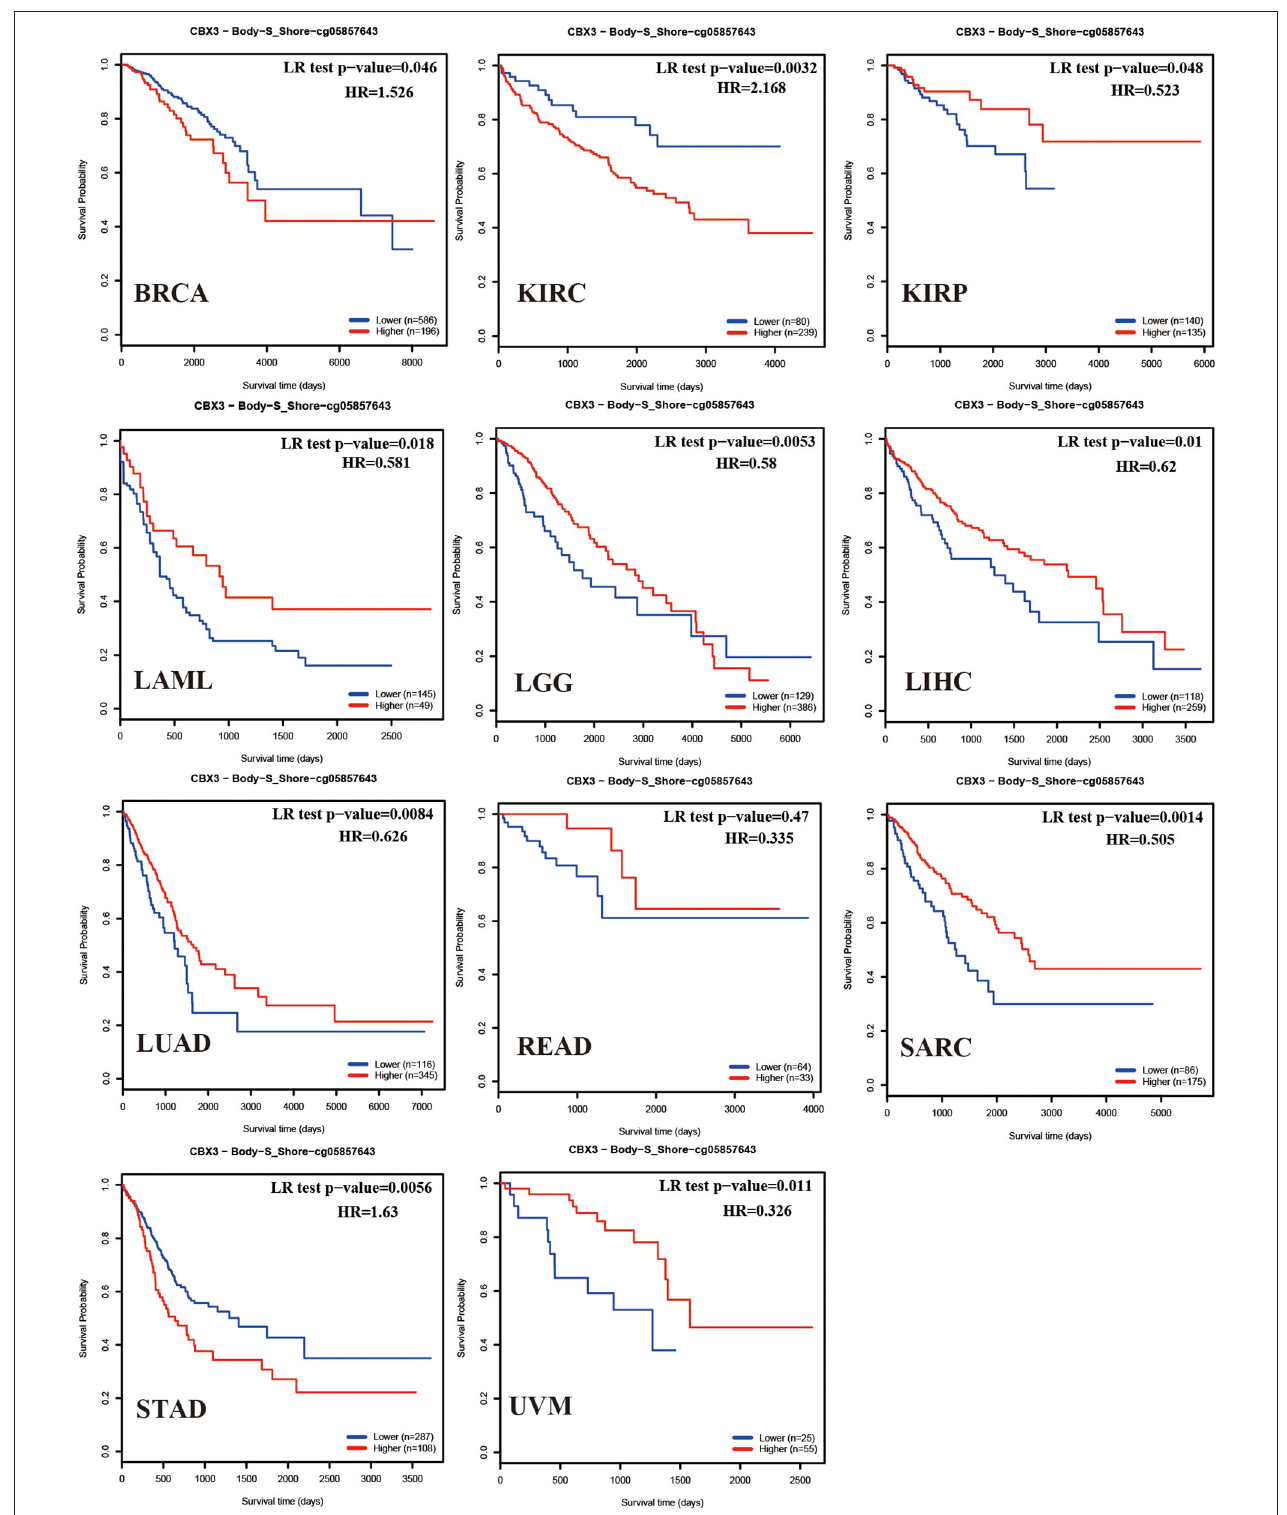
FIGURE 13 | Correlation between CBX3 methylation and OS of various tumors.